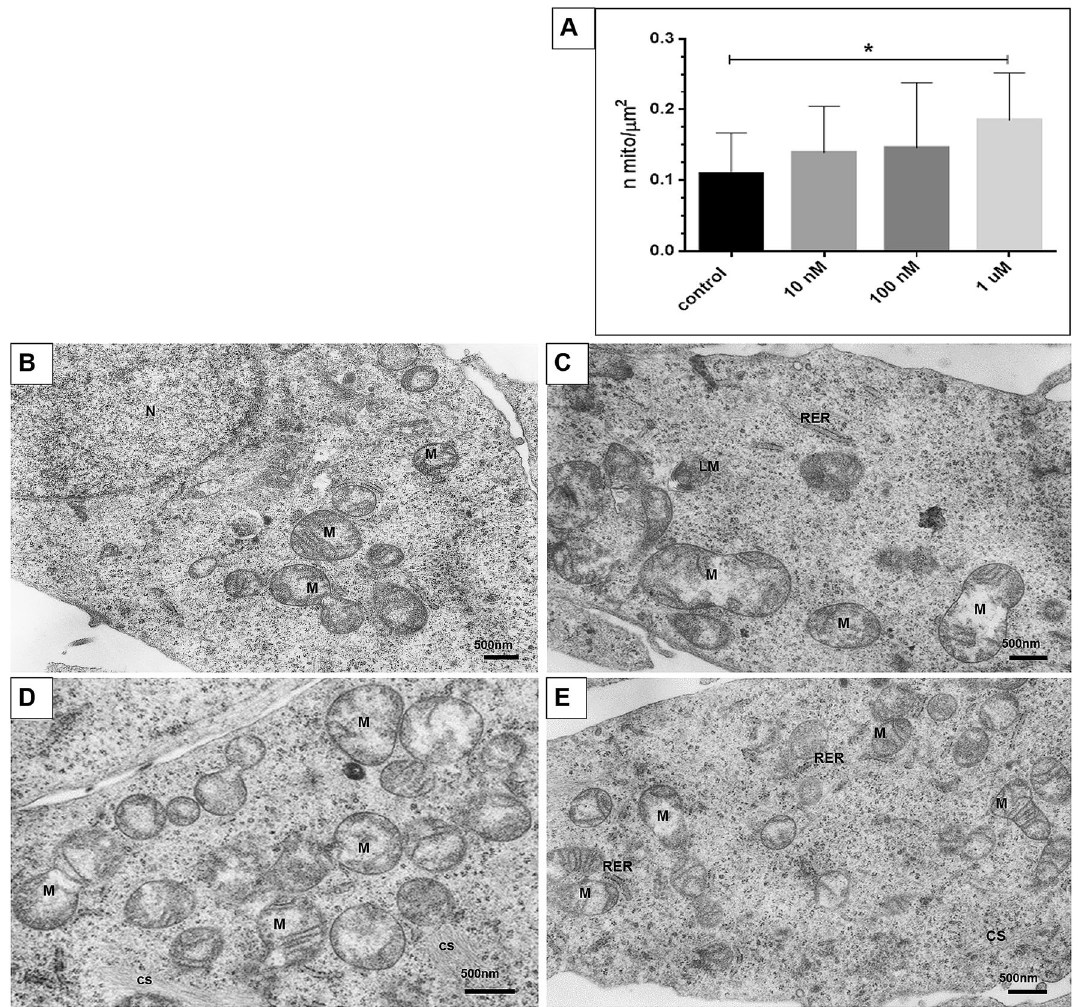
Figure 1. Electron microscopic analysis of osteosarcoma 143B cells treated with 2-ME. The cells were incubated in serum- and amino acid-free medium with 2-ME at the concentration of 10 nM, 100 nM and 1 µM 2-ME for 8 h, fixed and processed for transmission electron microscopy. ( A ) Morphometric analysis of mitochondria area density. 2-ME at the concentration of 1 µM significantly increased the number of mitochondria/µm 2 of cytoplasm. Statistical analyses were performed using GraphPad Prism (v. 6.0; San Diego, CA, USA). After checking for the outlier values with the Grubbs’s test, the normal distribution of data sets was established with the Shapiro–Wilk test and Student’s t-test was used to assess statistical significance of the differences that was set at p < 0.05. Data present mean ± SD. * p < 0.05 vs control value. ( B ) Control cells contain moderate number of mitochondria (M), cell nucleus (N) with abundant euchromatin. ( C ) 2-ME, 1 µM. Abundant large mitochondria, lamellar body formation (LM), cisterna of rough endoplasmic reticulum (RER). ( D ) 2-ME, 100 nM. Numerous mitochondria in the cytoplasm, cytoskeletal filaments (cs). ( E ) 2-ME, 10 nM. Abundant mitochondria with thin, elongated cristae and electron-light matrix accompanied by RER. Magnifications: ( A )—20,000×, (B–D)—10,000×